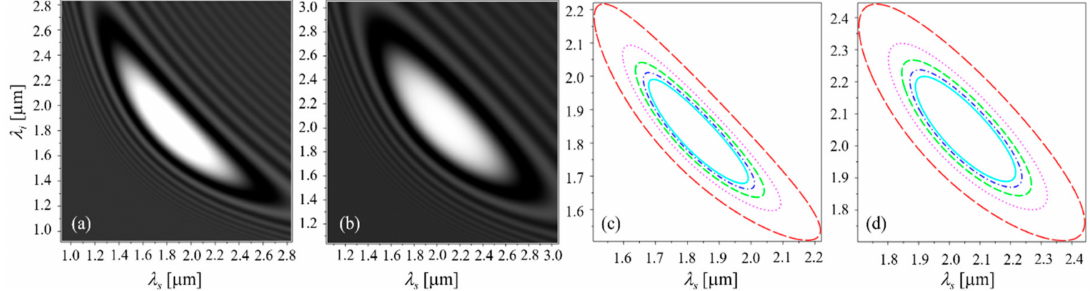
Figure 8. JSI without pump filtering for Type I ( a ) case (1), ( b ) case (2); the contour line of JSI = 0.5 ( c ) case (1), ( d ) case (2). The crystal lengths used in the simulation are 10, 20, 30, 40, 50 mm in order of decreasing the area inside the